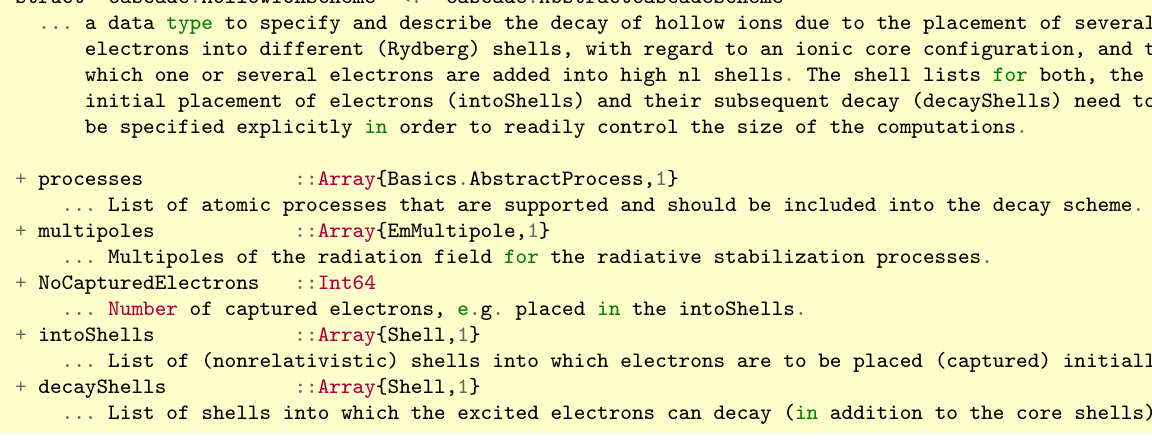
struct Cascade.HollowIonScheme <: Cascade.AbstractCascadeScheme